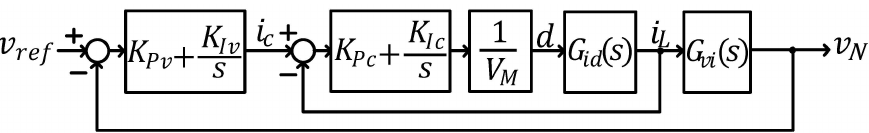
Figure 8. Control block for current and voltage